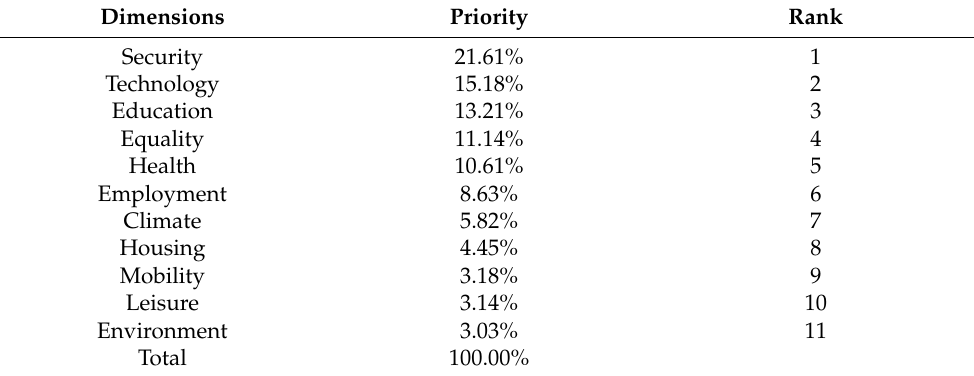
Table 3. AHP priority